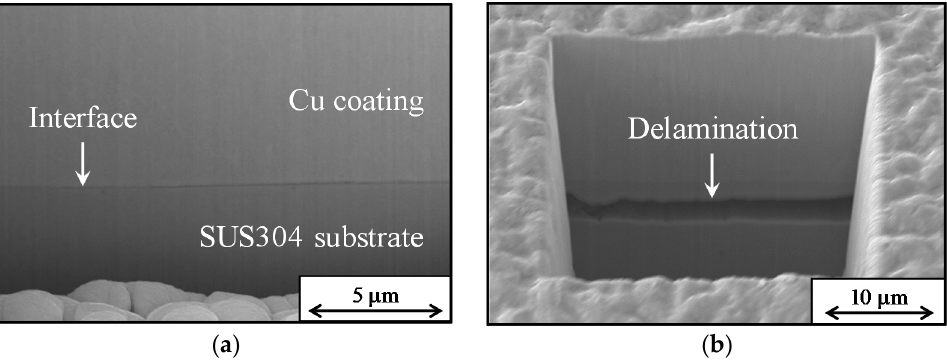
Figure 2. SEM cross-sectional images of the specimen before ( a ) and after LaSAT ( b ) [18]. Table 1. Material properties of stainless-steel (SUS304) substrate and electroplated Cu coating [18]. Material